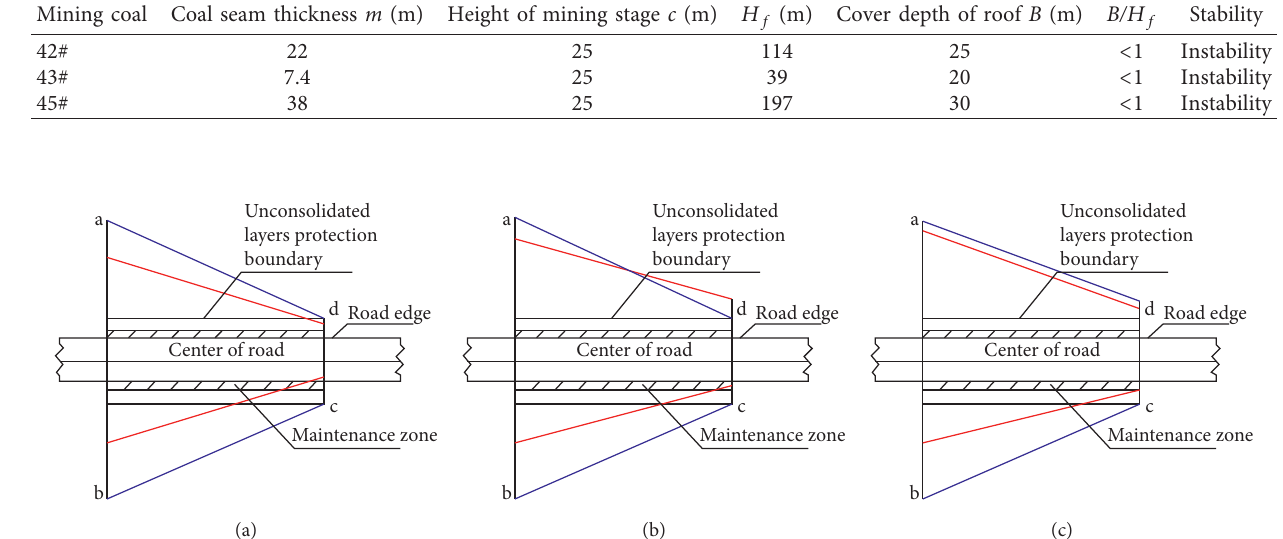
Figure 9: (a) Boundaries of 45# coal pillar. (b) Boundaries of 43# coal pillar. (c) Boundaries of 4# coal